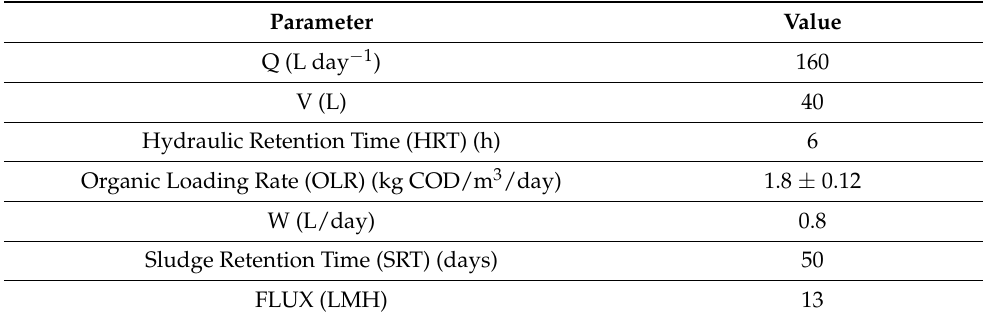
Table 2. Operating characteristics of